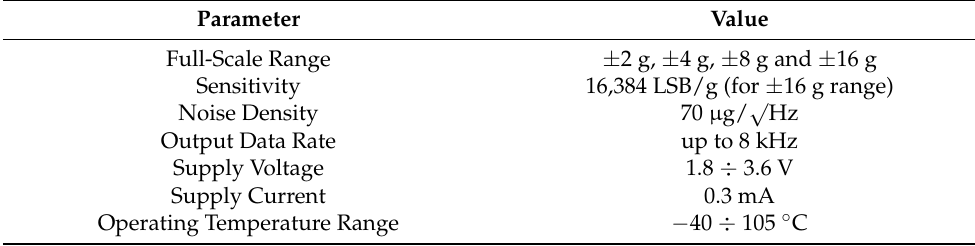
Table 2. MEMS accelerometer (TDK IIM-42351) main